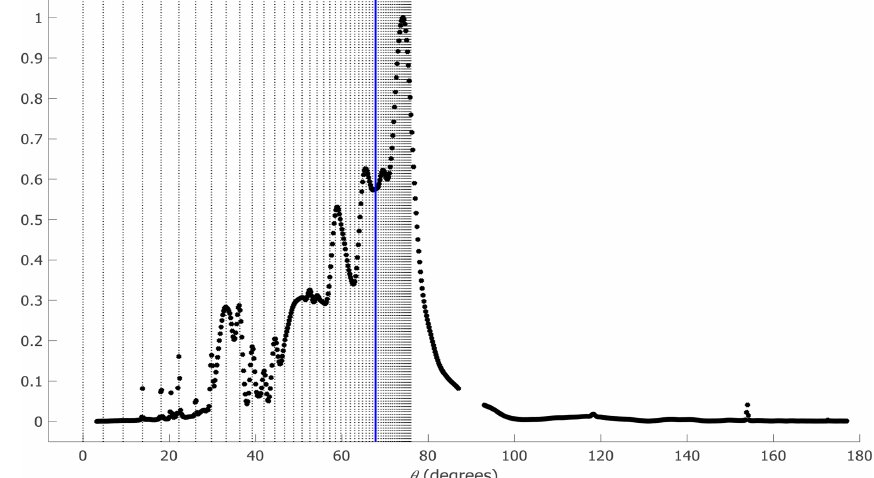
Figure 5. The distribution of the sum of squares of the Radon transform (black dots) versus the Radon angle θ . Clearly, the distribution of the corresponding input propagation speeds (vertical dashed black lines) as a function of θ is not uniform due to the nonlinear relation between C and θ